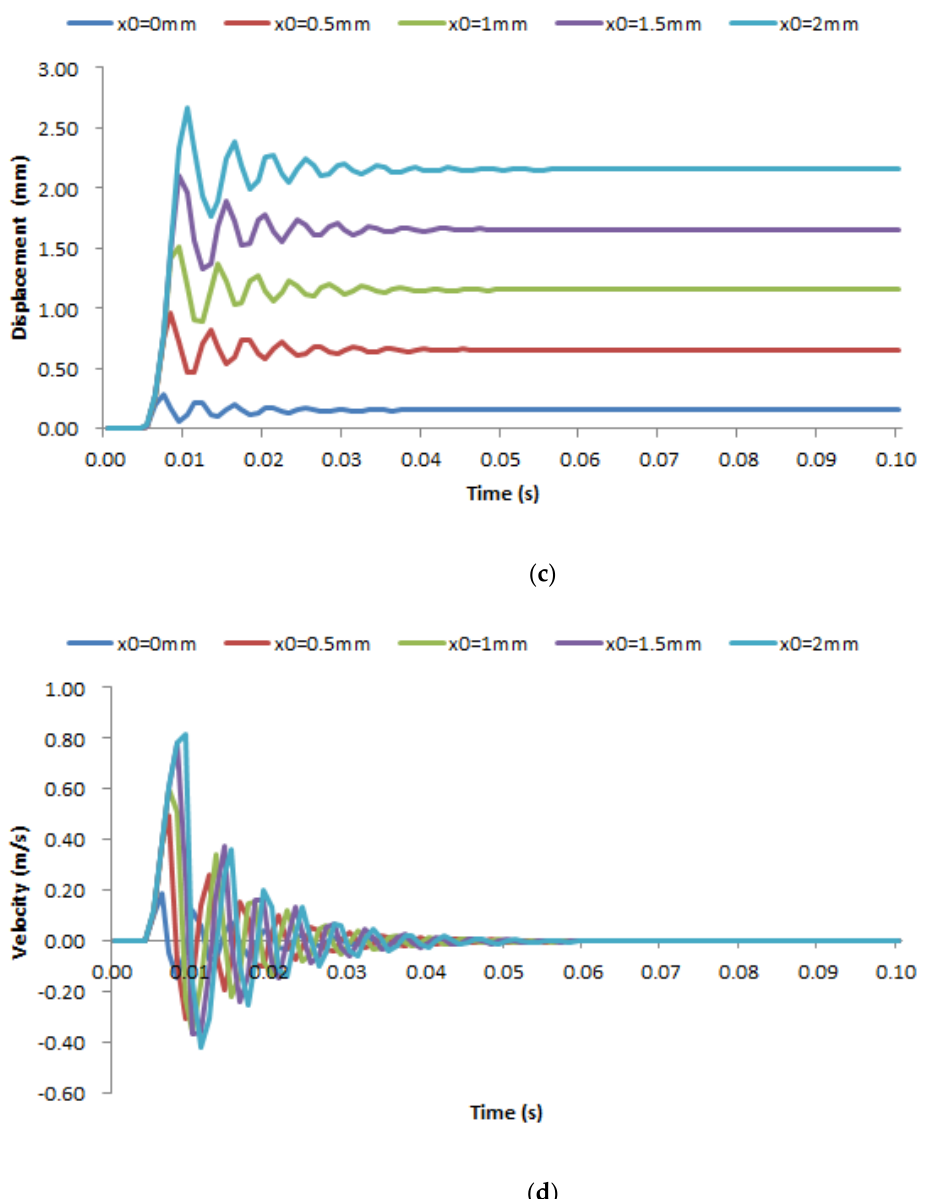
Figure 14. ( a ) The pressure response characteristics—oil sealing length: 0~2 mm. ( b ) The flowrate response characteristics—oil sealing length: 0~2 mm. ( c ) The displacement response characteristics—oil sealing length: 0~2 mm. ( d ) The velocity response characteristics—oil sealing length: 0~2 mm.